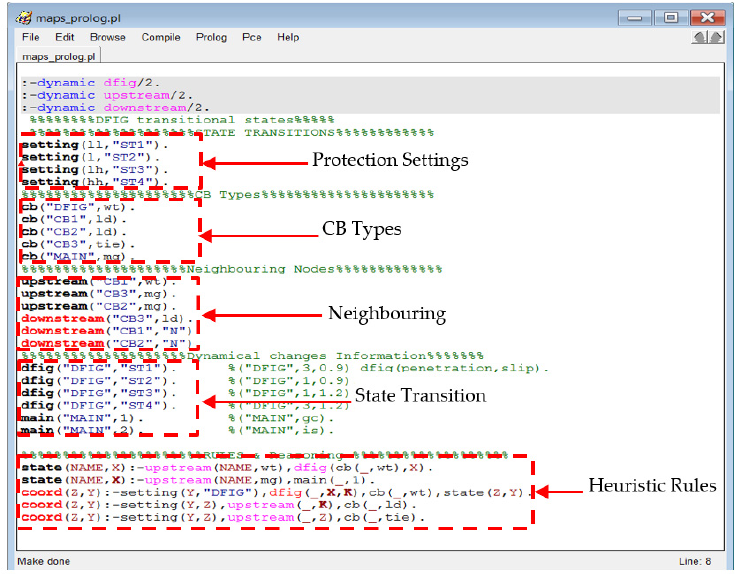
Figure 10. Knowledge database developed in PROLOG to automate selection of protection settings within the proposed MAPS.